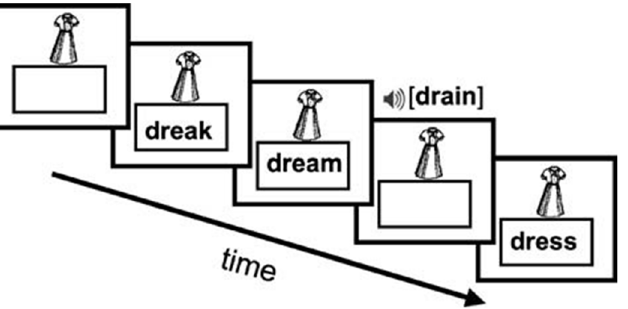
Fig 2. Schematic of fMRI paradigm. A picture cue is displayed and participants make identity match/ mismatch judgments to print and speech